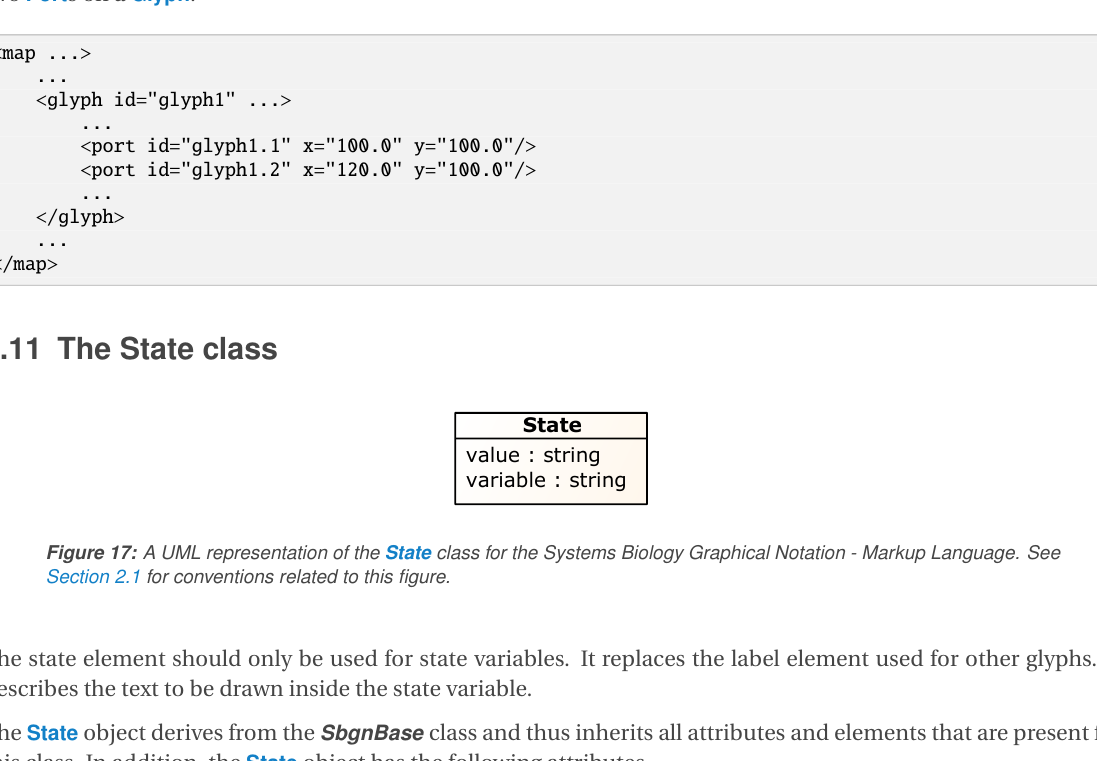
The state element should only be used for state variables. It replaces the label element used for other glyphs. It 25 describes the text to be drawn inside the state